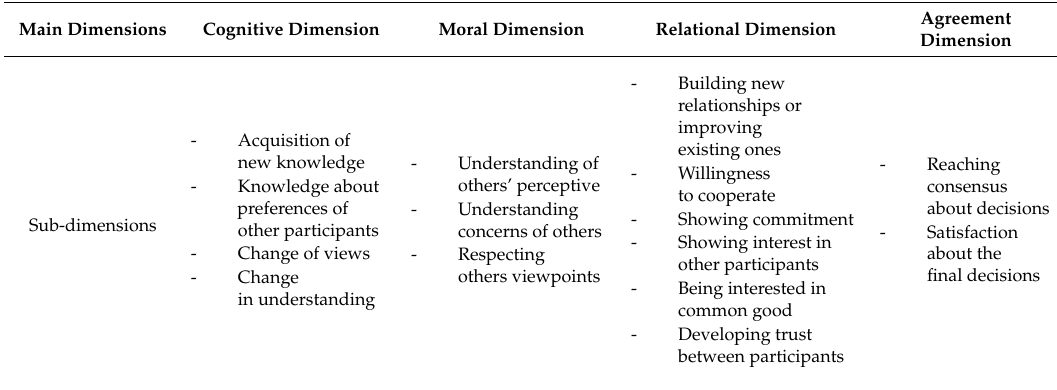
Table 1. Classification of potential outcomes for social learning as identified in relevant